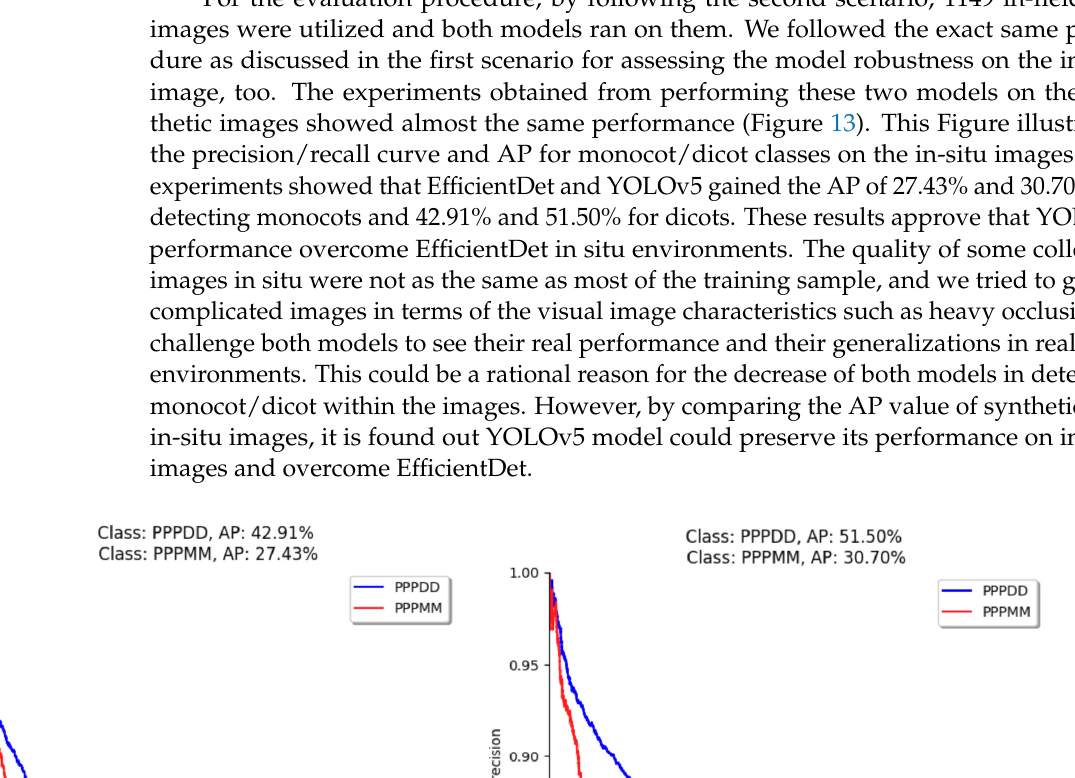
monocot and crops in the field environments. Providing more labeled data and variation in in the training set could be helpful to enhance the recognition performance. the training set could be helpful to enhance the recognition